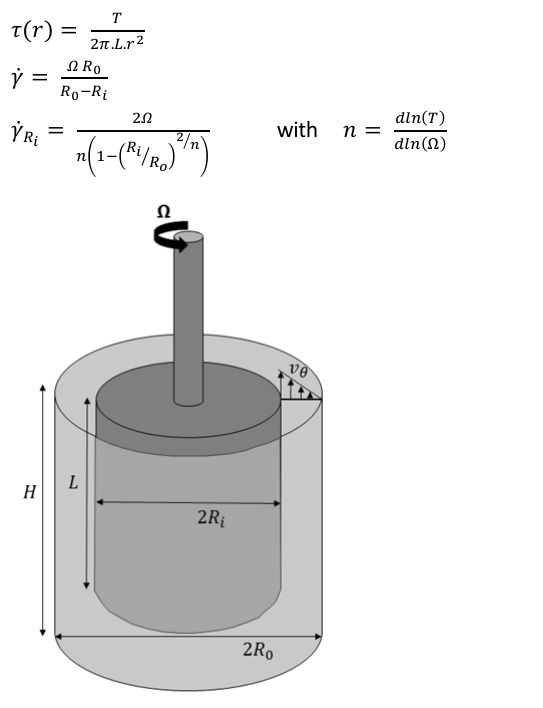
Figure 1. Concentric cylinders